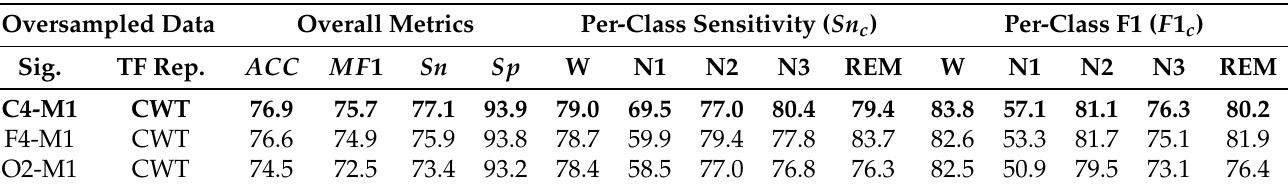
Table 6. Overall test performance with CNN-RNN transfer learning networks and oversampled CWT-TF training images across three different EEG channel inputs.